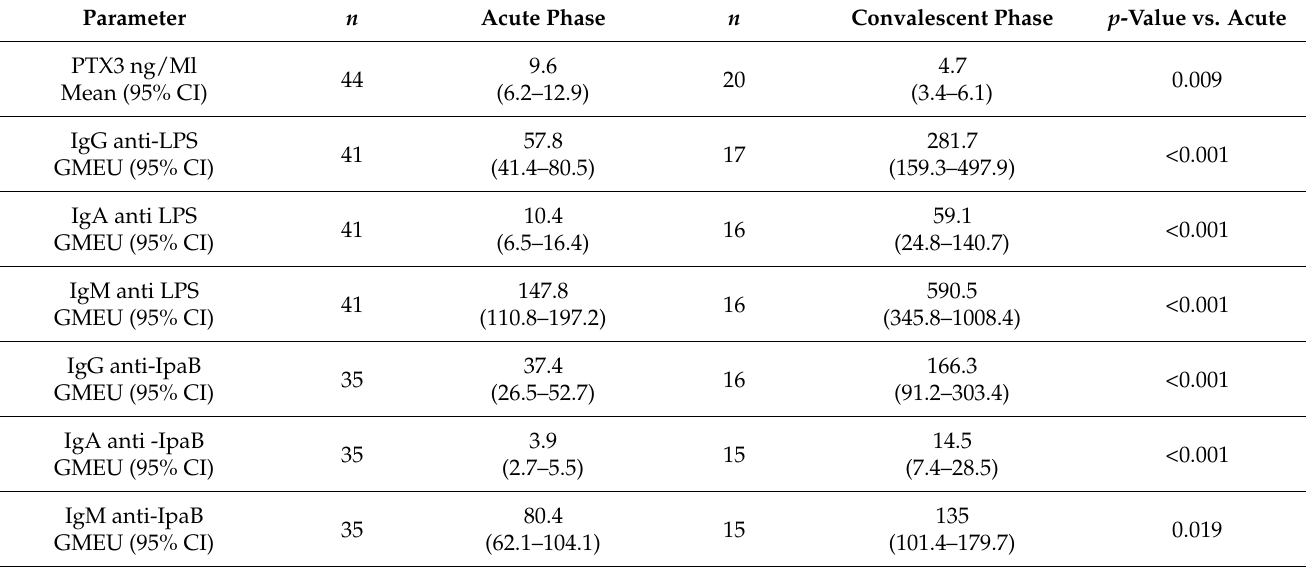
Table 1. Study groups and levels of PTX3 and antibodies to S. sonnei LPS and IpaB antigens in serum